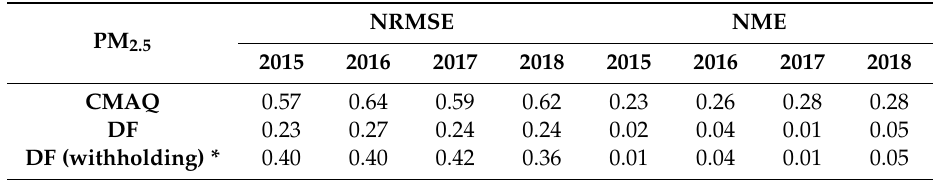
Table 2. Normalized root mean square error (NRMSE) and normalized mean error (NME) of Community Multiscale Air Quality (CMAQ) model simulated and data-fused daily total PM 2.5 concentrations with respect to observations during the first four months of each year (2015–2018). PM